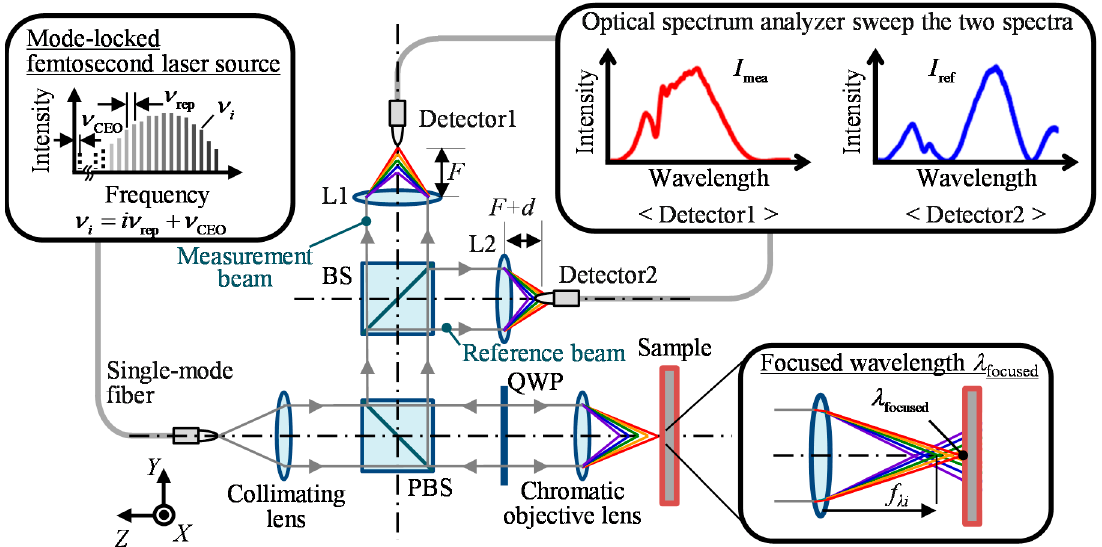
Figure 3. Principle of the mode-locked femtosecond laser chromatic confocal probe (BS: Beam splitter, PBS: Polarized beam splitter, QWP: Quarter-wave plate, L1 and L2: Fiber coupling lenses).